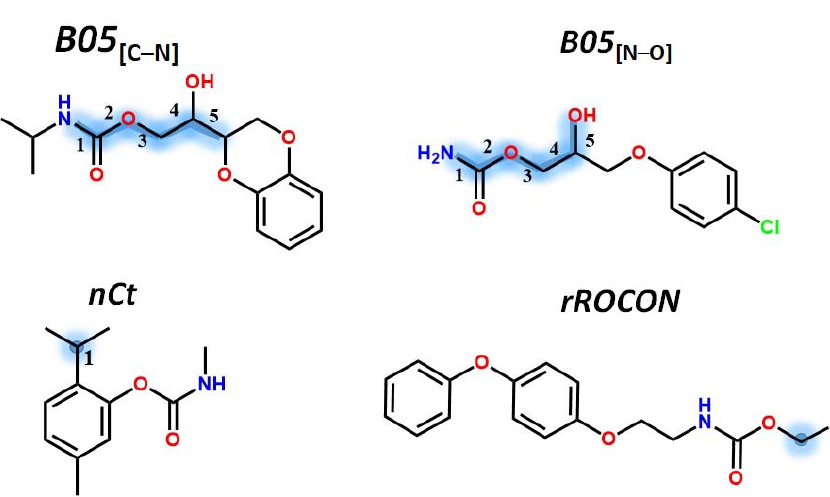
Figure 3. Variables are illustrated using some compounds of the set and marked with blue on the